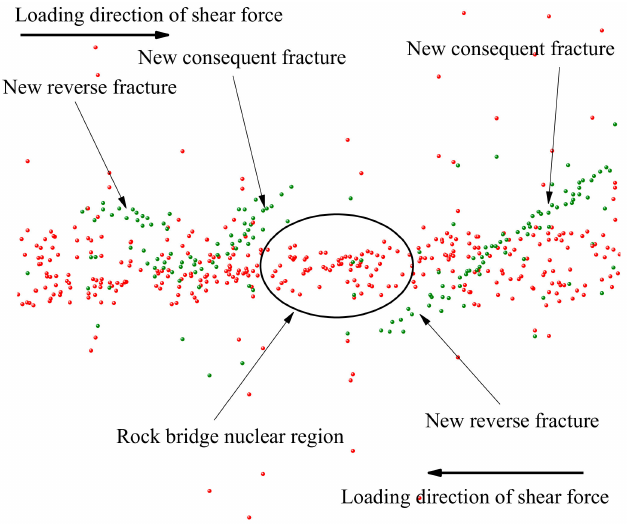
Figure 20. Change curve of tangential stress and change rule of cumulative AE counts.